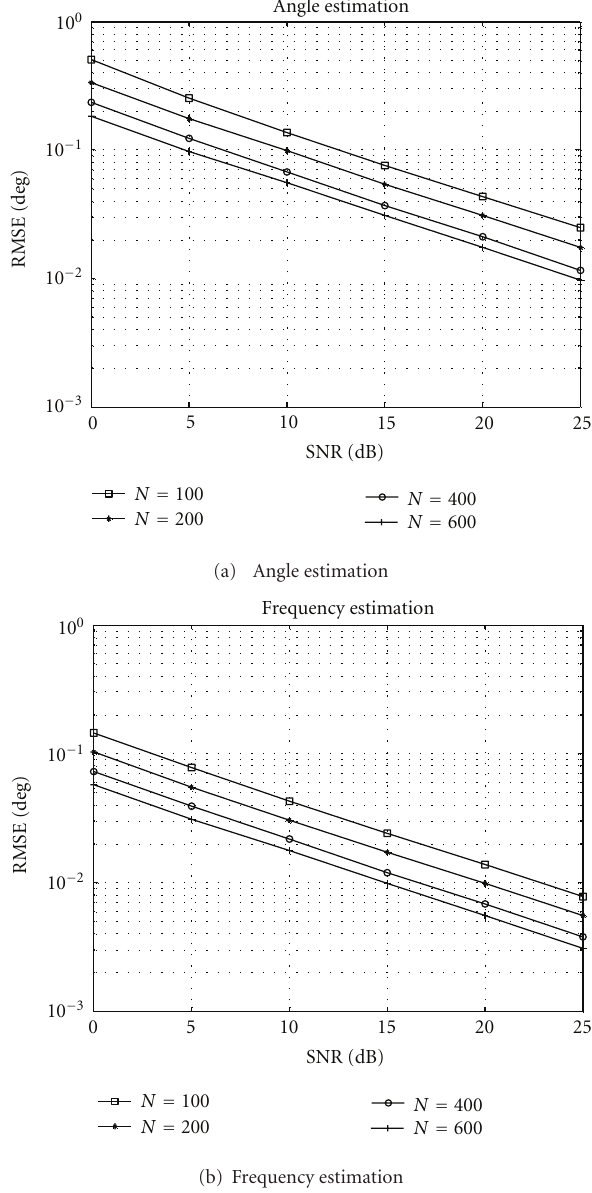
Figure 8: Angle-frequency estimation with di ff erent snapshot N